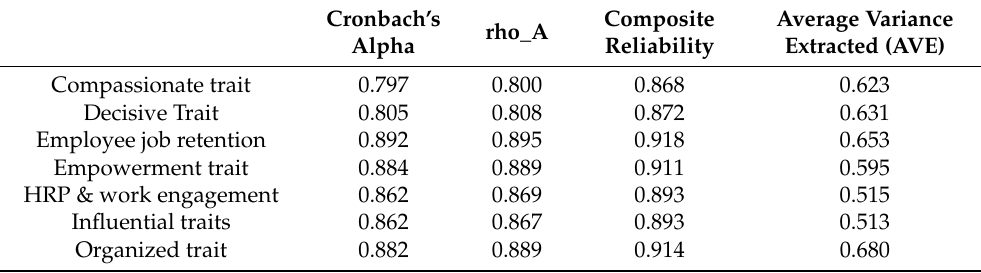
Table 2. Reliability and convergent